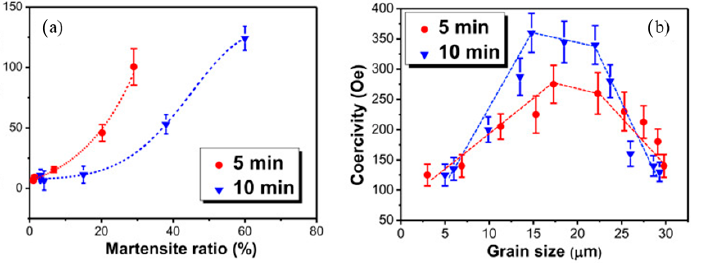
Figure 8. Comparison of the data at the same depth for ( a ) the variation of magnetization with martensite ratio; and ( b ) variation of the coercivity with grain size. Reproduced with permission from [83]. Copyright Elsevier, 2020.